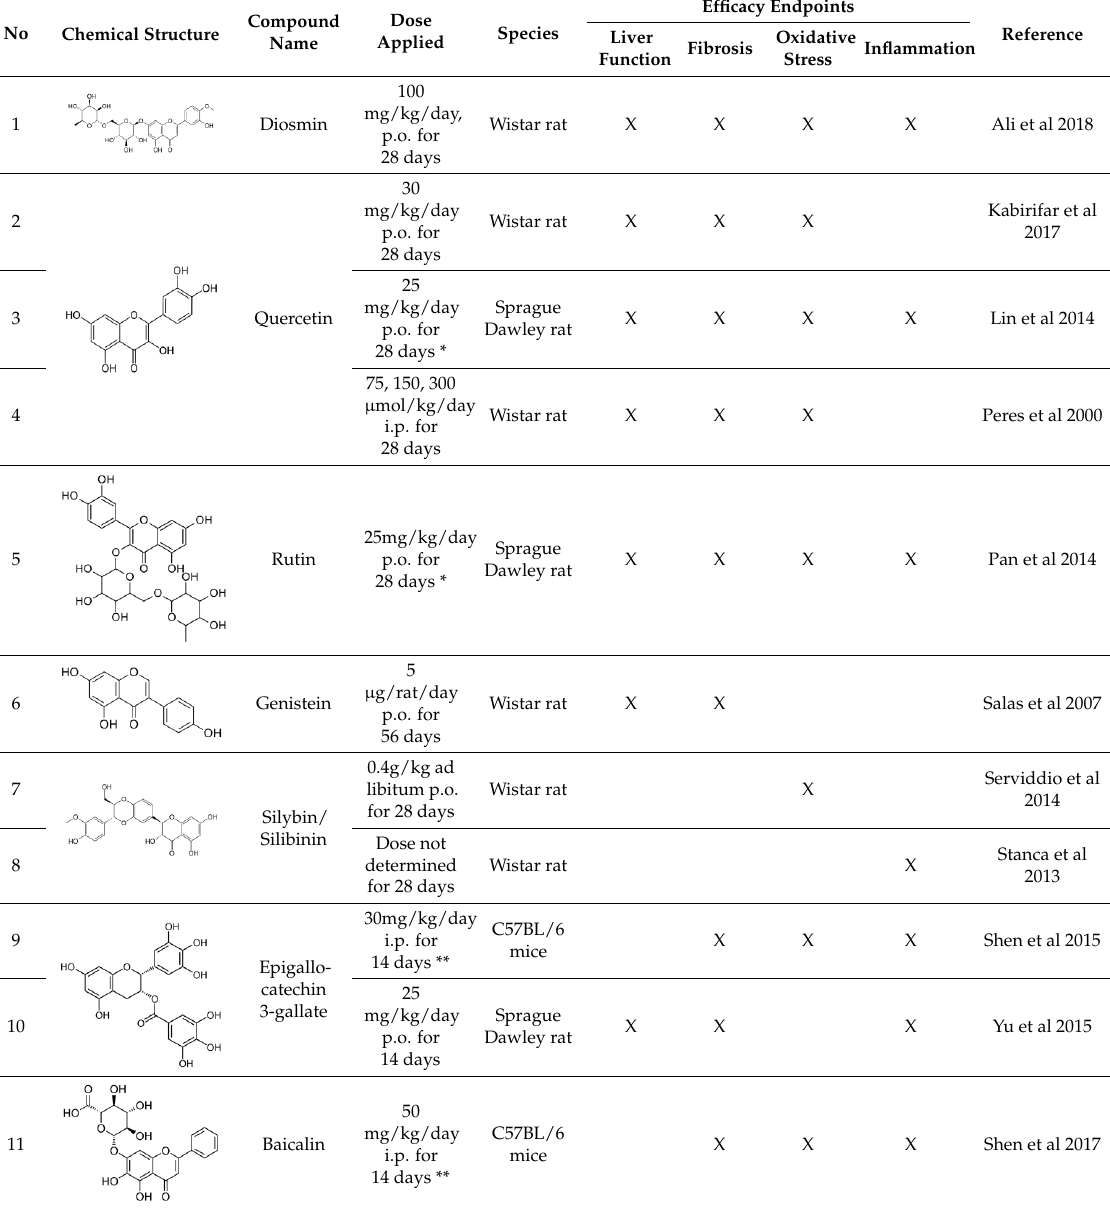
Table 1. Efficacy endpoints studied on selected articles of systematic review.